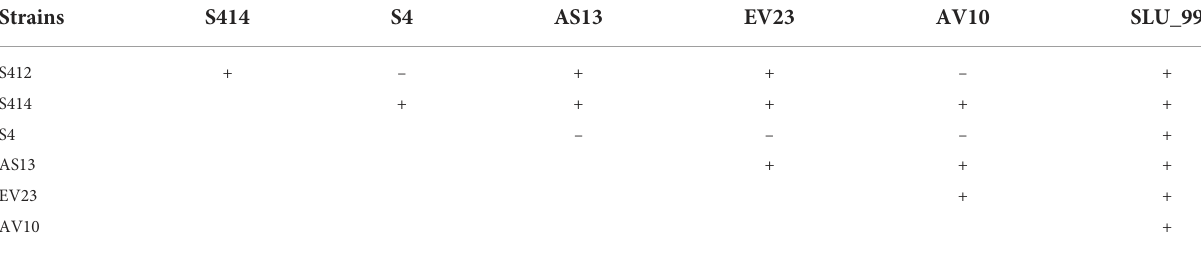
TABLE 1 Compatibility assay between co-inoculated